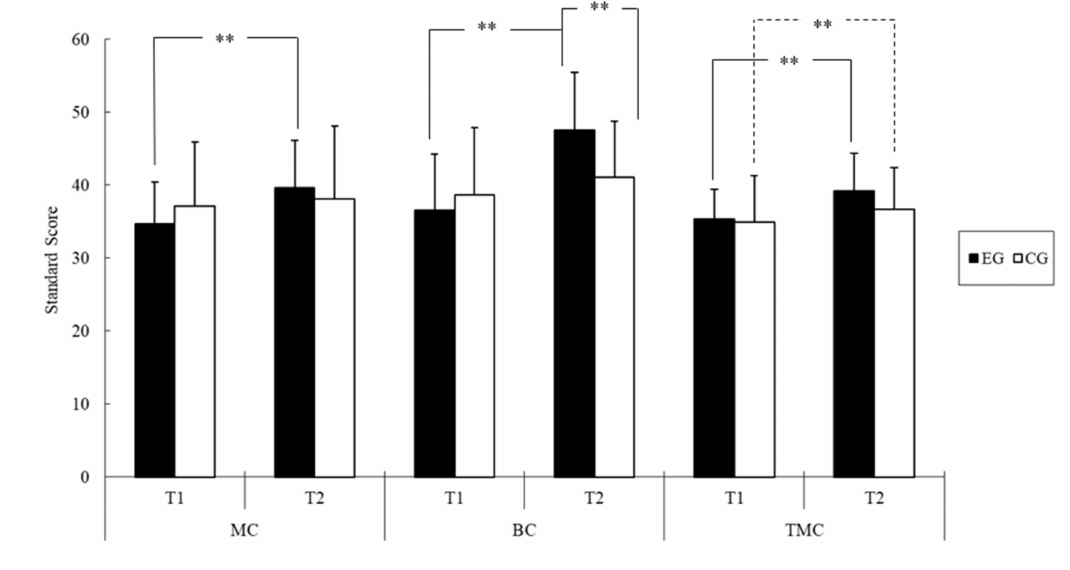
Figure 1. The BOT-2 standard score of two groups of youths with IDs before (T1) and after the intervention (T2); ** p < 0.01 (Abbreviations: MC = manual coordination; BC = body coordination; TMC = total motor composite; EG = exercise group; CG = control